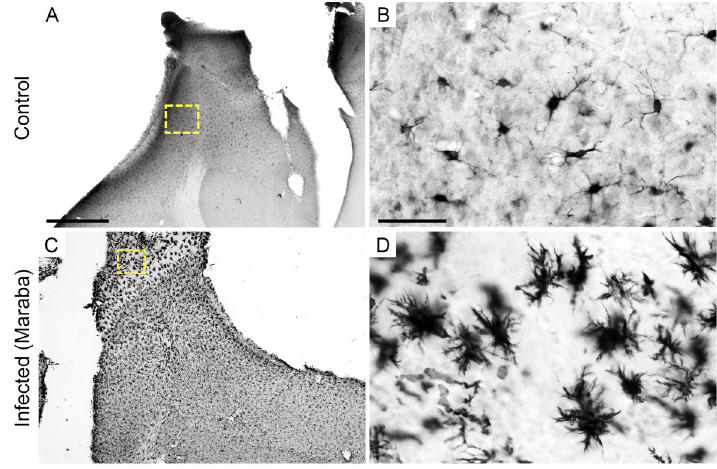
Figure 4 . Photomicrographs of mouse brain sections immunolabelled for Iba-1. Microglia in the olfactory bulb of control ( A and B ) and infected mice ( C and D ) sections at 3 days post-infection immunolabelled for Iba-1. Yellow-dotted squared areas indicate the regions of high-power images. Scale bars A and C : 650 m m; B and D : 30 m